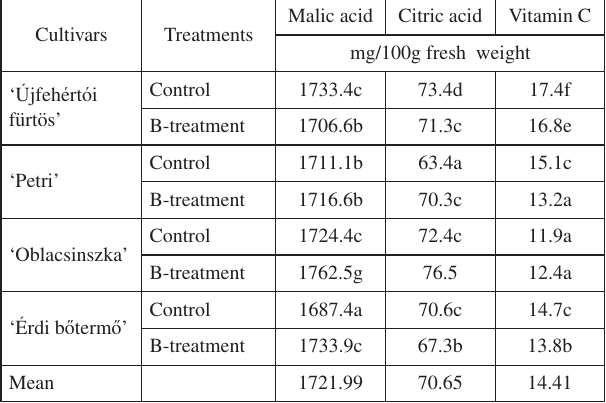
In each column, means followed by the same letter are not significantly different